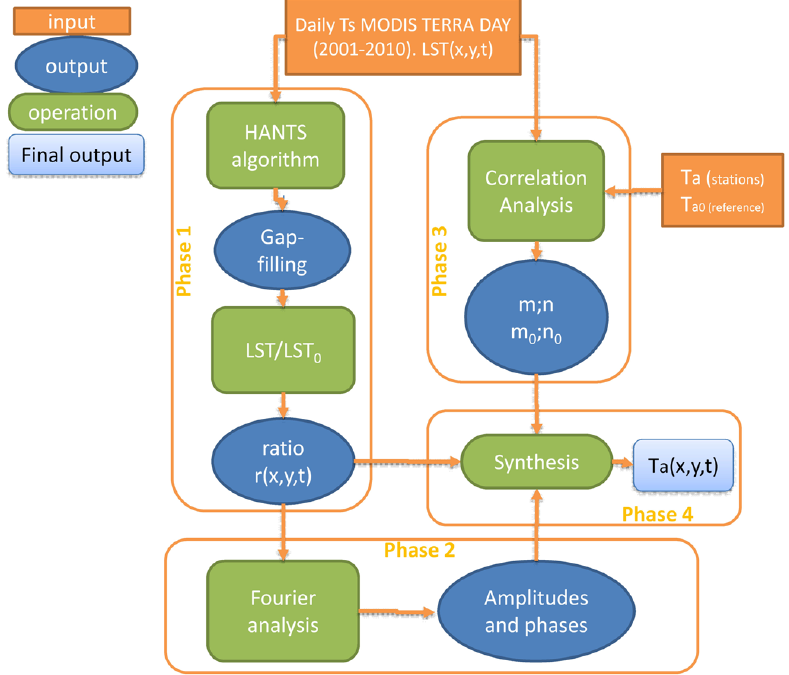
Fig. 1. Schematization of the SINTESI